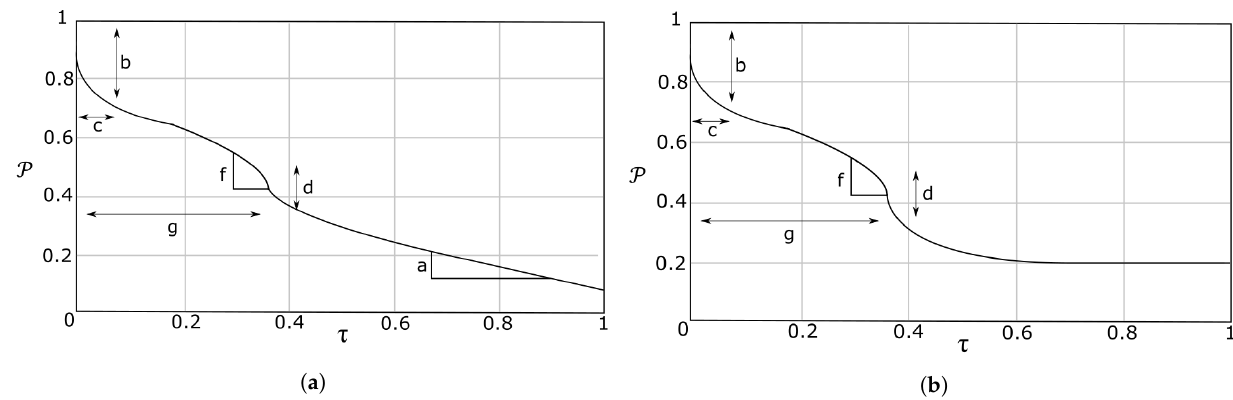
Figure 2. ( a ) Shape of the 6-parameter LDC for commercial, institutional and industrial consumers [23], and ( b ) shape of the proposed 5-parameter LDC for low-voltage